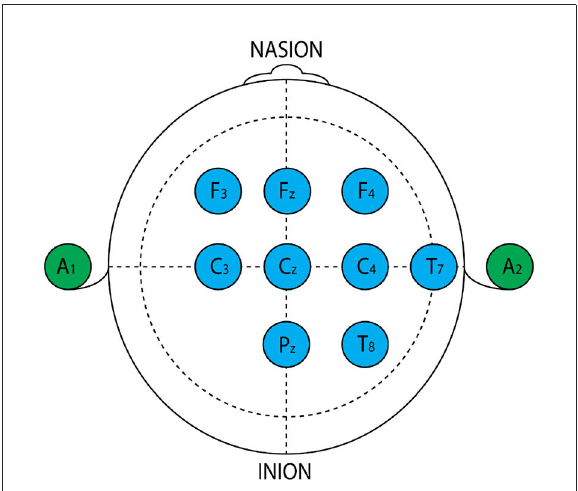
FIGURE1 Placement of the electrodes. Blue color: electrodes used in our experiment.